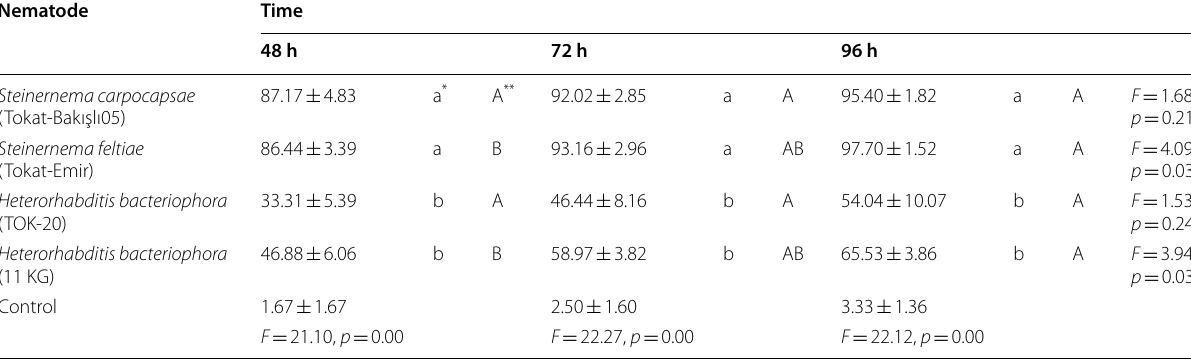
Table 8 The mortality rate of third stage cotton leafworm larvae at different exposure times